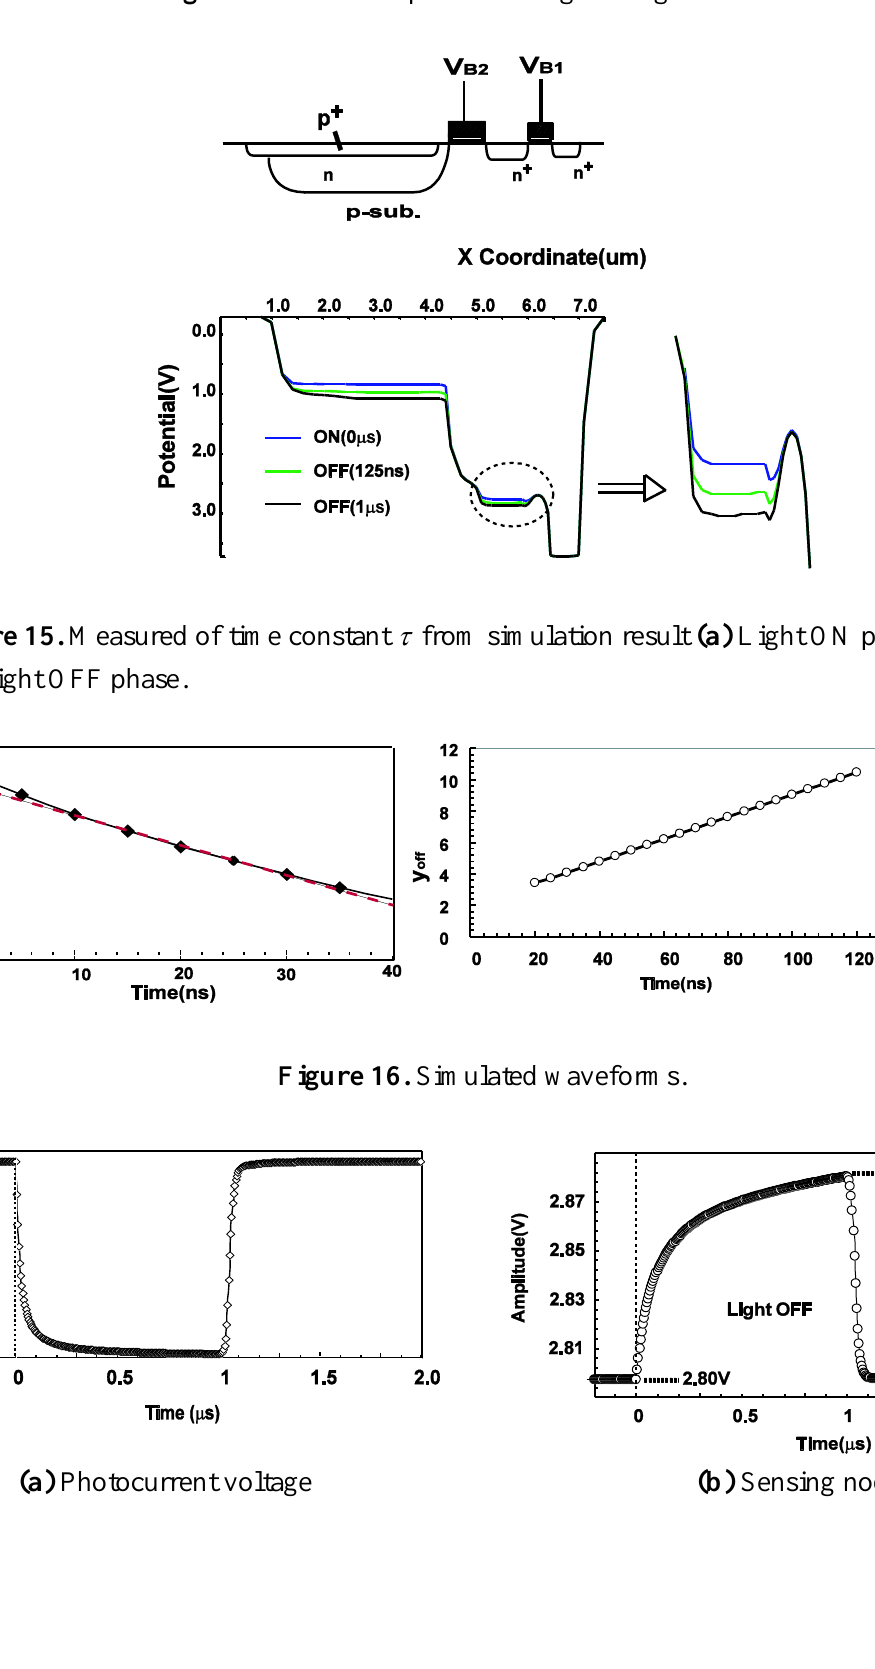
Figure 14. Potential profile during turning on and off.